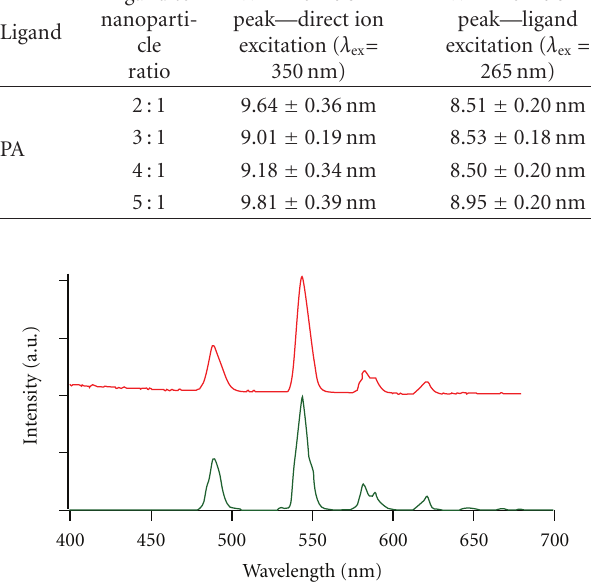
Figure 11: Emission of Tb 3+ doped LaF 3 in PMMA nanocom- posites composed of 2:1 PA ligand to ion ratio at two di ff erent excitation wavelengths (red- λ ex = 350 nm and green- λ ex = 265 nm) The spectra are normalized to the 540nm